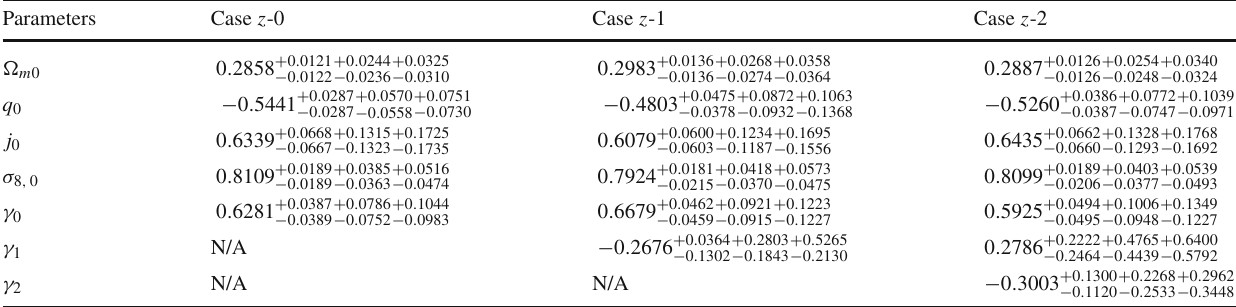
Table 2 The mean with 1 σ , 2 σ , 3 σ marginalized uncertainties of the model parameters for the cases with the z -cosmography and γ = γ 0 (labeled as “ z -0”), γ = γ 0 + γ 1 z (labeled as “ z -1”), γ = γ 0 + γ 1 z + γ 2 z 2 (labeled as “ z -2”). See the text for details